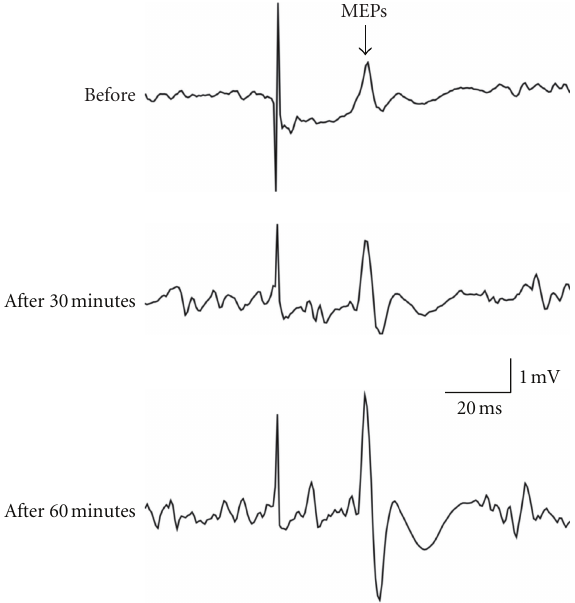
Figure 3: A sample of changes in MEPs of FDI muscle during TMS with MVC under the test 2 condition.